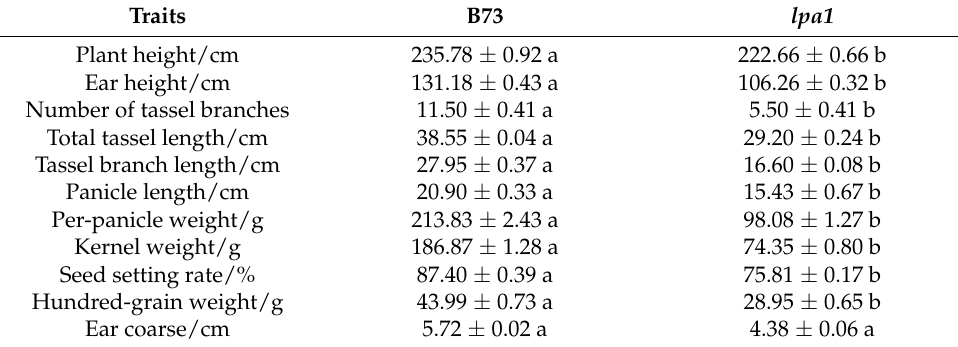
Table 2. Investigation of agronomic characters of wild-type B73 and mutant lpa1 .